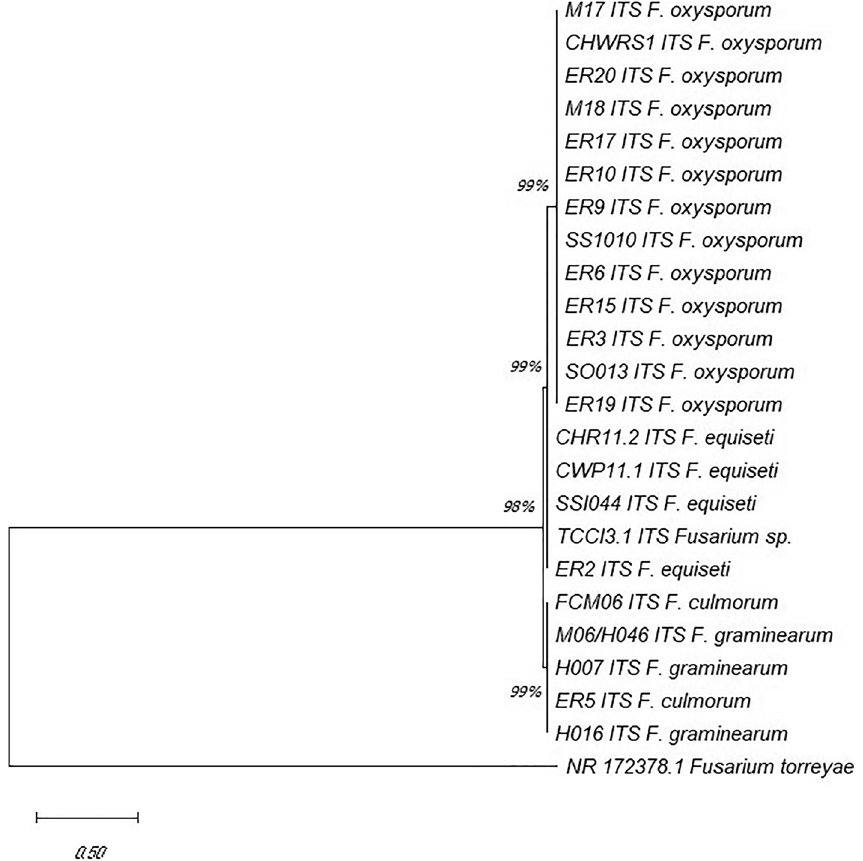
Figure 3. Phylogenetic tree of Fusarium isolates in quinoa, based on neighbor-joining analysis of the ITS gene. Bootstrap values are from a bootstrap test of 1000 replicates. OM117609.1 corresponds to F. torreyae outgroup.